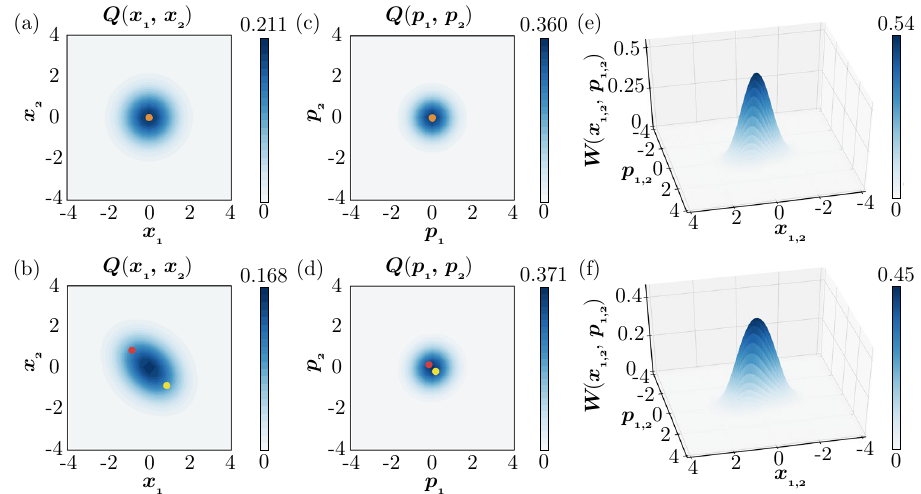
Figure 4. Turing instability in a pair of diffusively coupled quantum activator–inhibitor units in the weak quantum regime. ( a , b ) 2D plots of the Q distribution Q ( x 1 , x 2 ) . ( c , d ) 2D plots of the Q distribution Q ( p 1 , p 2 ) . ( e , f ) 3D plots of the stationary Wigner distributions W ( x 1 , p 1 ) and W ( x 2 , p 2 ) of units 1 and 2 (identical to each other). Red and yellow dots in ( a – d ) represent stable fixed points of the deterministic system in the classical limit. In ( a , c , e ), the two units are uncoupled. The states of the units are localized around the origin and uncorrelated with each other. In ( b , d , f ), the two units are diffusively coupled. Due to the Turing instability, the two units tend to take different states from each other and show a nonuniform distribution. The parameters 0.3 . The diffusion 0.6, γ 1 1.2, γ 2 0.5, θ π , and η of the quantum activator–inhibitor units are � = = − = = = 0 ) in ( a , c , e ) and D 0.005 and D 0 ( D 0.995 ( D 0 and D 0.99 and D p constants are D x c = x = p = h = h = − = = 1 ) in ( b , d , f ). D c =